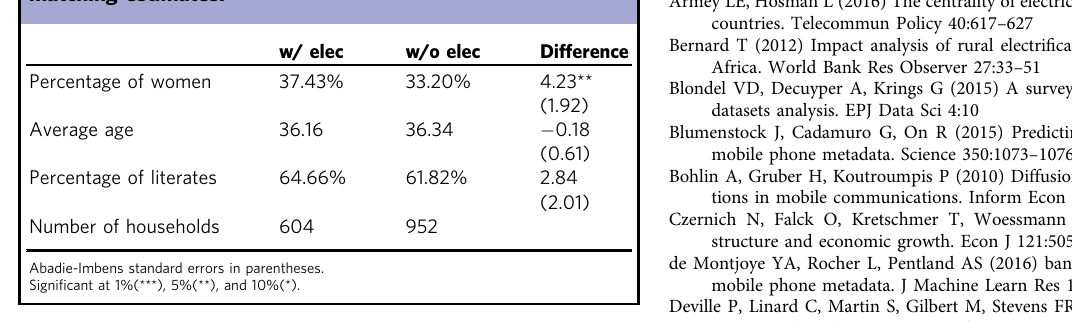
Table 6 Pro fi le of rural mobile subscribers-propensity score matching